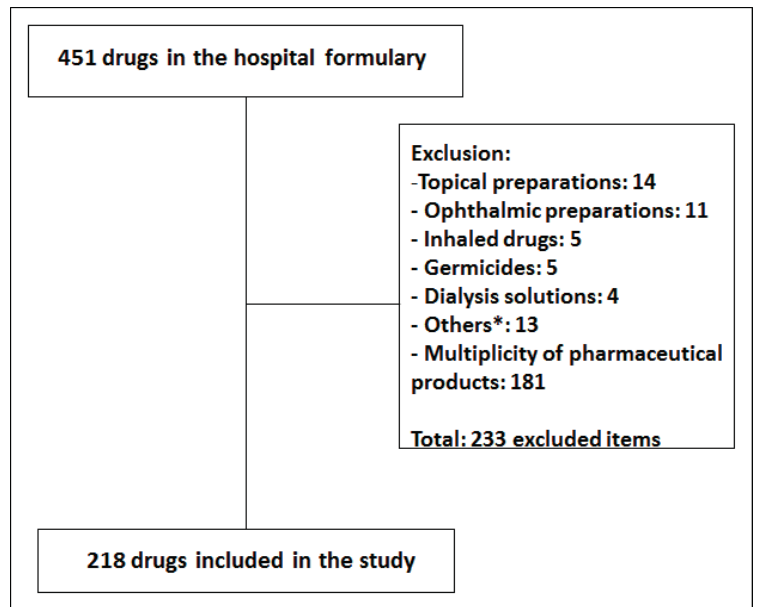
Figure 1. Flow chart for the selection of studied drugs. * Others included: tissue adhesives, diagnostic agents, suppositories, absorbable haemostatic, fibrin sealant, soda lime, activated carbon and absorbable gelatin